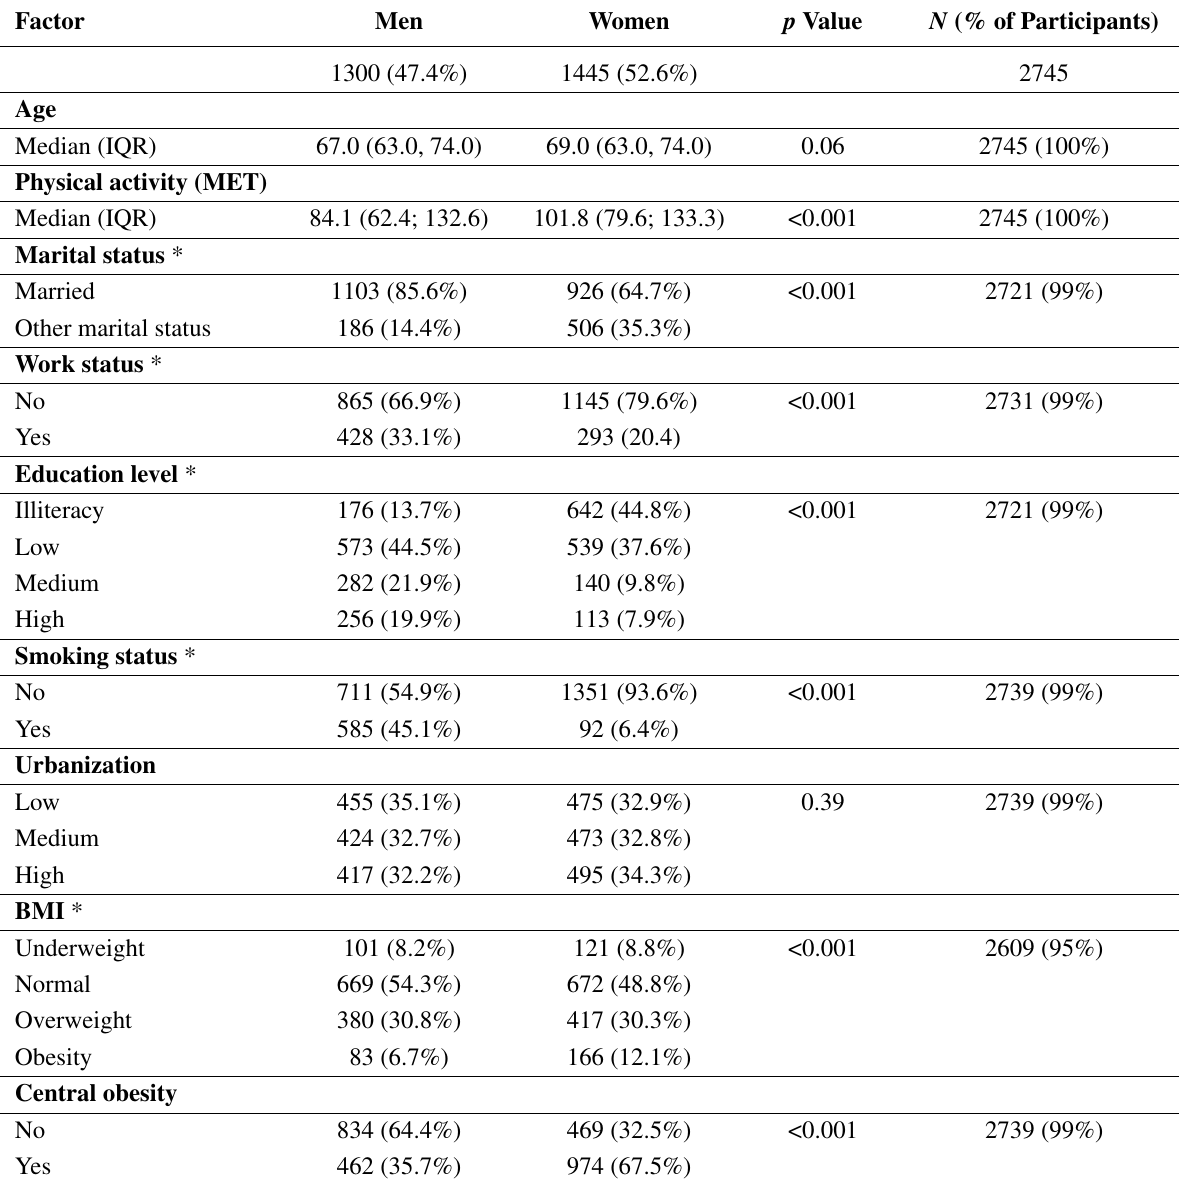
Table 1. Characteristics of study